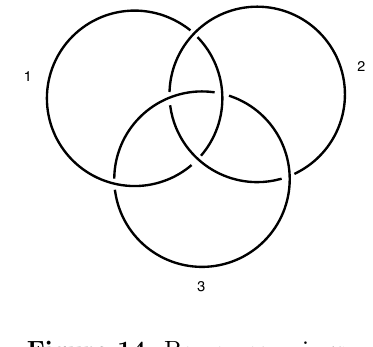
Figure 14 . Borromean rings.